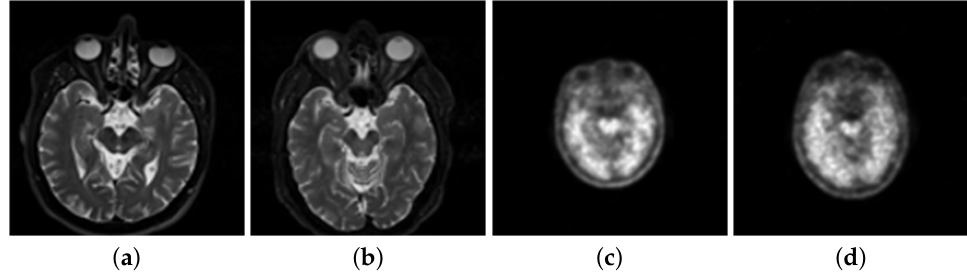
Figure 2. ( a ) Magnetic resonance image (MRI) of patients. ( b ) MRI of normal people. ( c ) Positron emission tomography (PET) image of patients. ( d ) PET image of normal